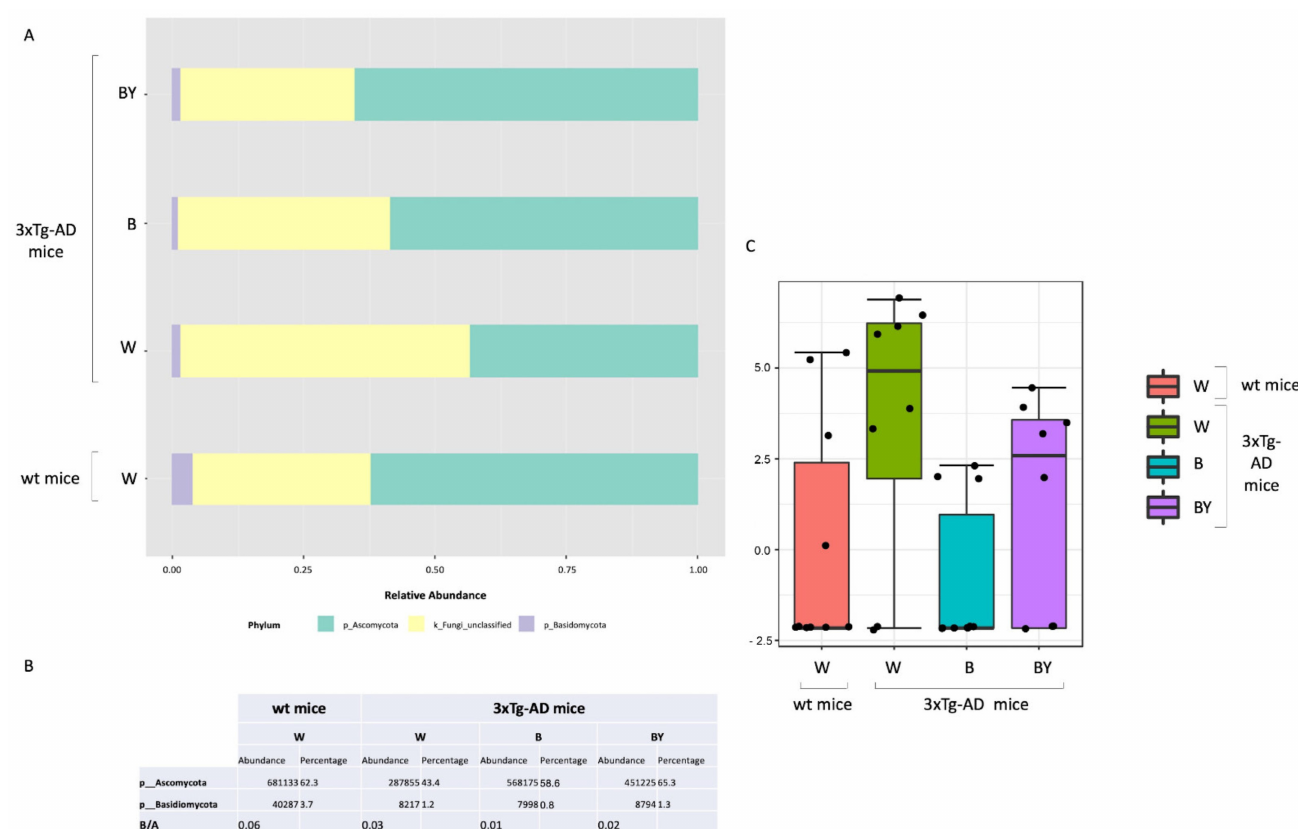
Figure 10. Fungal profiles at the phylum level obtained with the phylogeny-based taxonomy assign- ment approach. The identified phyla are reported for each study group (panel A ). Basidiomycota and Ascomycota phyla reads abundance, percentage and ratio are also reported (panel B ). The c_Sordariomycetes_unclassified order was the only significantly different taxa among the tested condi- tions (panel C